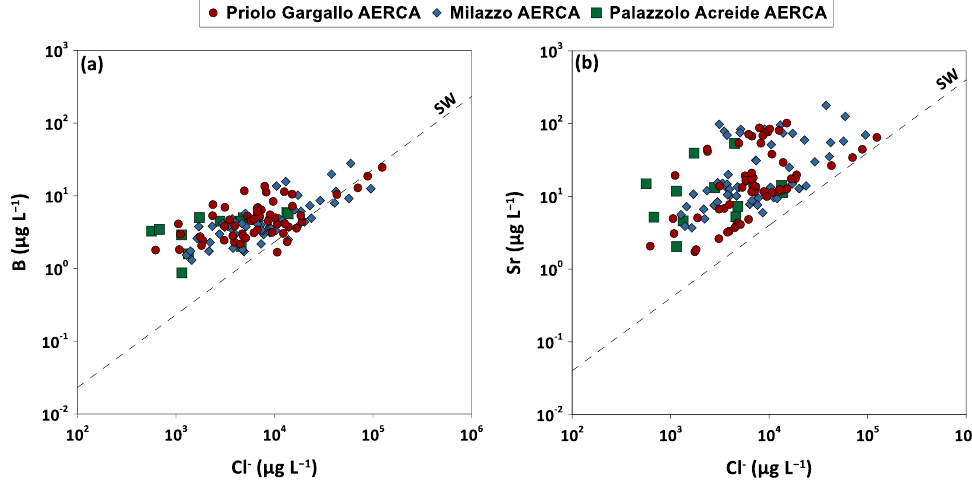
Figure 6. Correlation between boron ( a ) and strontium ( b ) against chloride (μg L −1 ). The straight lines (SW) are the seawater ratios.